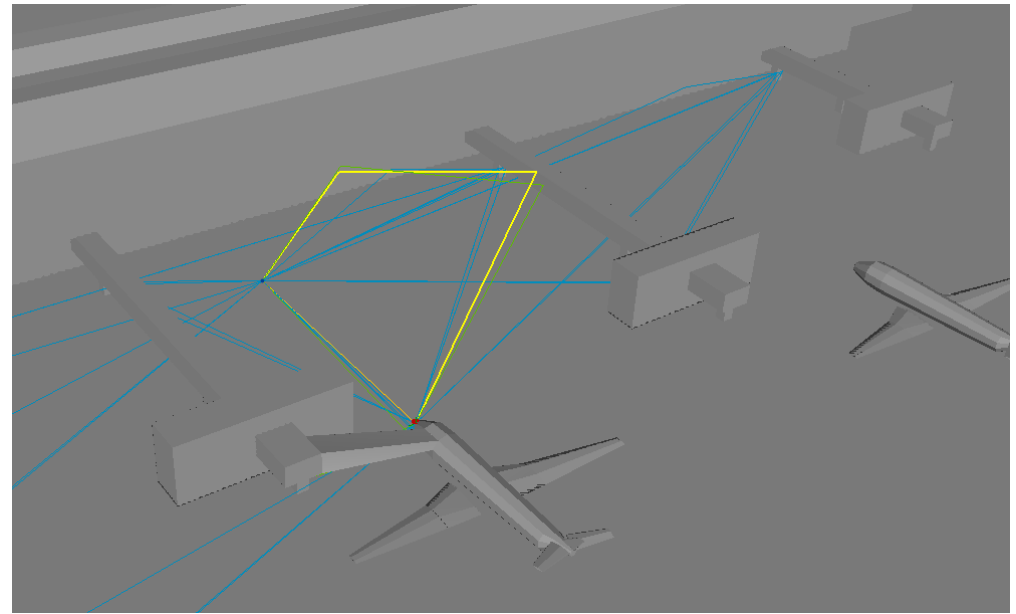
Figure 6. Ray-tracing scenario at the airport.